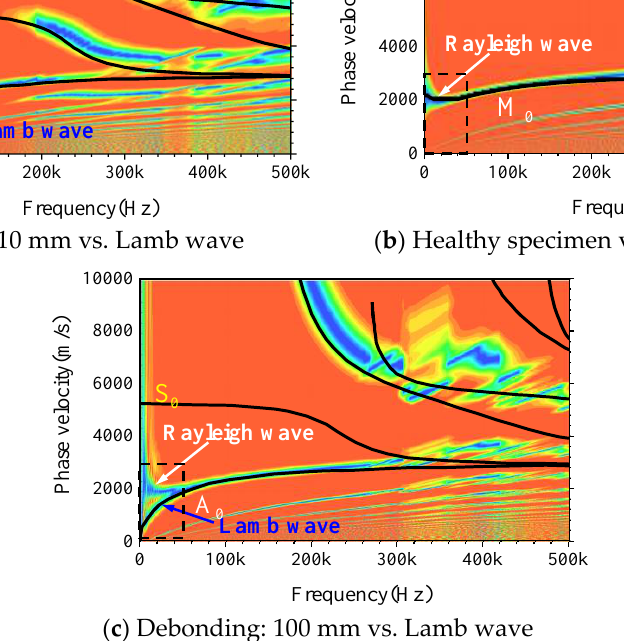
Figure 12. The comparison of dispersion curves from the forward analysis and theoretical calculation.